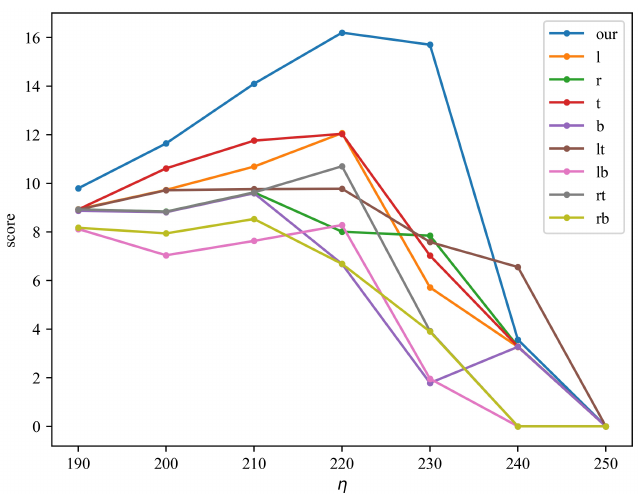
Figure 9. The scores of different locations with different thresholds η . where the y-axis represents the score and the x-axis indicate different thresholds η , which can control the size of the patch. The broken lines of different colors represent the scores when the patch is placed in different positions of the target, and the blue one is the score broken lines obtained by our proposed method under different thresholds.